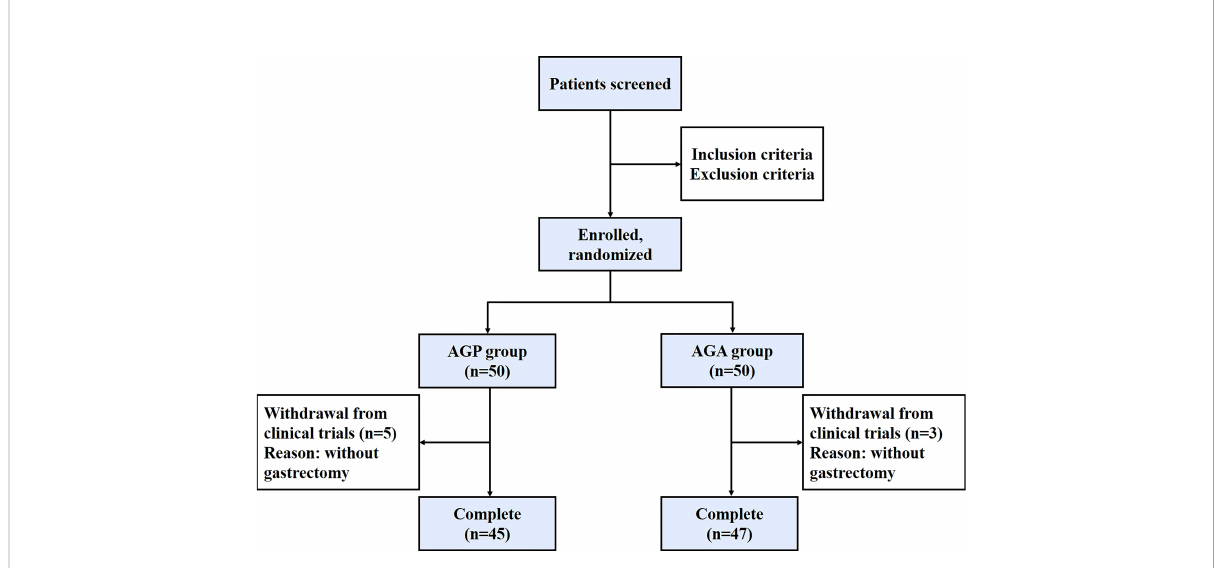
FIGURE 1 Patient enrollment chart in this study. AGP, gastric cancer patients and treatment with the placebo after gastrectomy; AGA, gastric cancer patients and treatment with the C. butyricum after